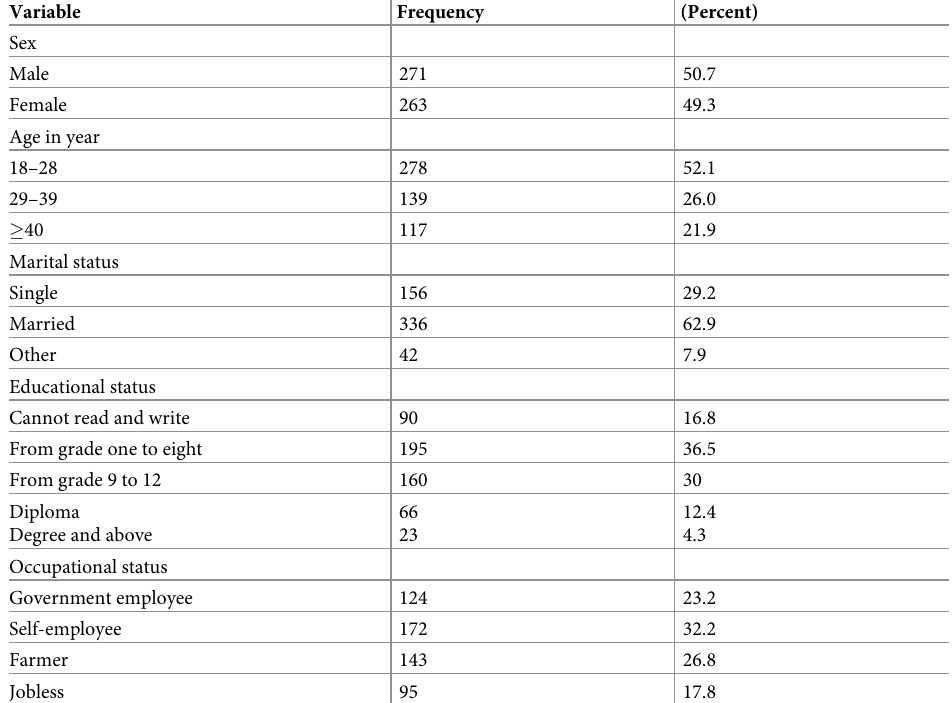
Table 2. Socio demographic characteristics of participants of Mizan-Aman town, south west Ethiopia, 2017 (n =